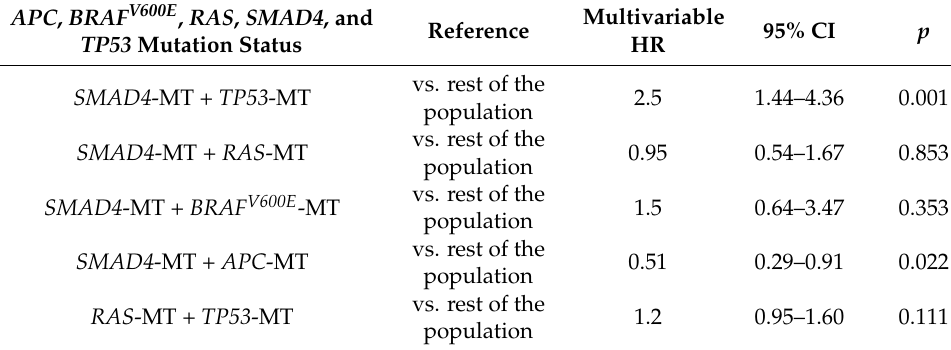
Table 4. Multivariate survival model analysis for OS by mutation status of APC , BRAF V600E , RAS , SMAD4 , and TP53